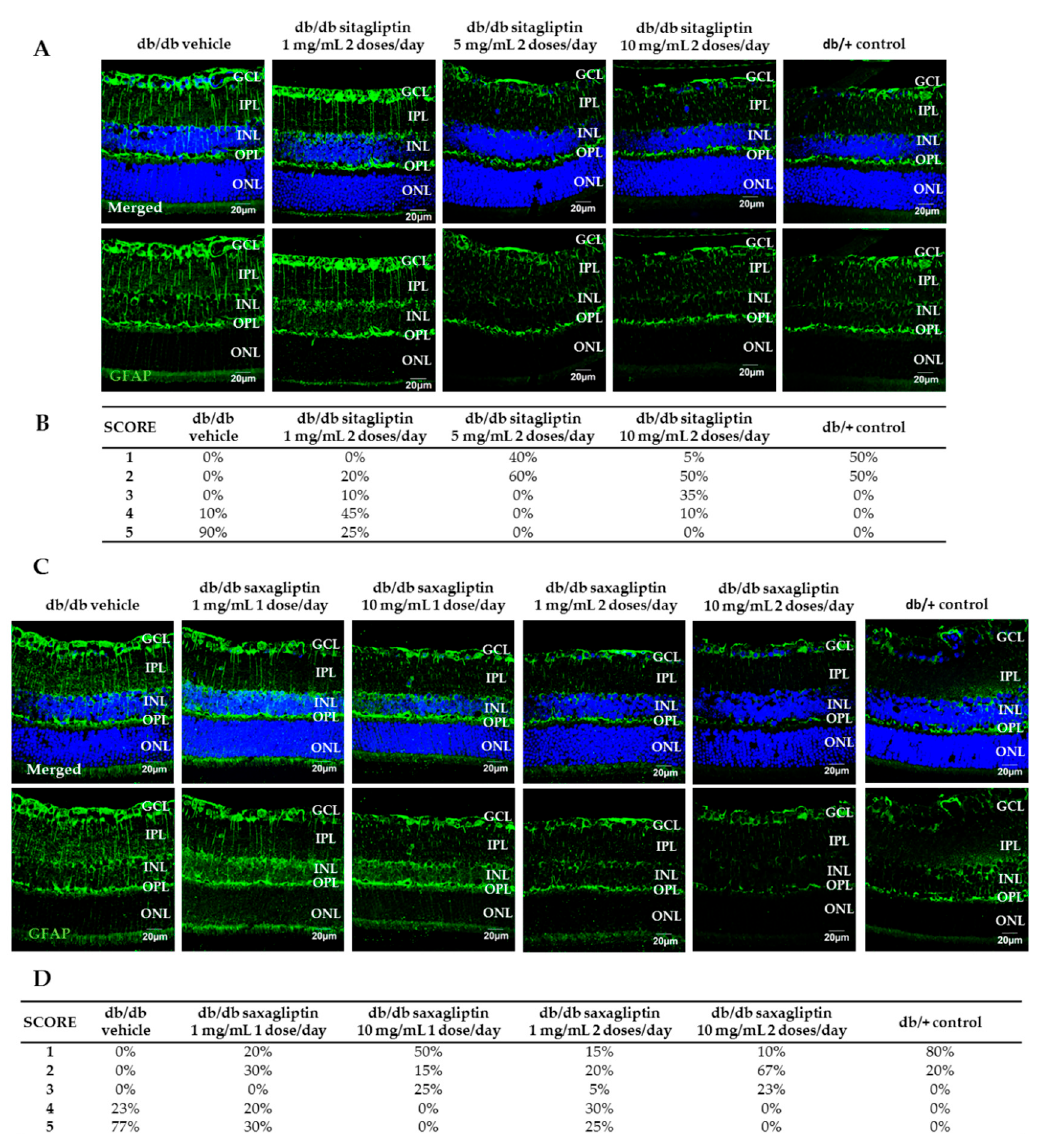
Figure 2. Reactive gliosis. ( A , C ) Comparison of GFAP immunofluorescence reactivity (green) among experimental groups to assess the dose ‐ efficacy effect of sitagliptin ( A ), and saxagliptin ( C ). GFAP relative fluorescence intensity is displayed isolated and merged with Hoechst nuclei staining (blue). ONL: outer nuclear layer; OPL: outer plexiform layer; INL: inner nuclear layer; IPL: inner plexiform layer; GCL: ganglion cell layer. Scale bars, 20 µ m. ( B , D ) Quantification of reactive gliosis based on the extent of GFAP staining. n = 4 mice per group and 5 retinal sections for each